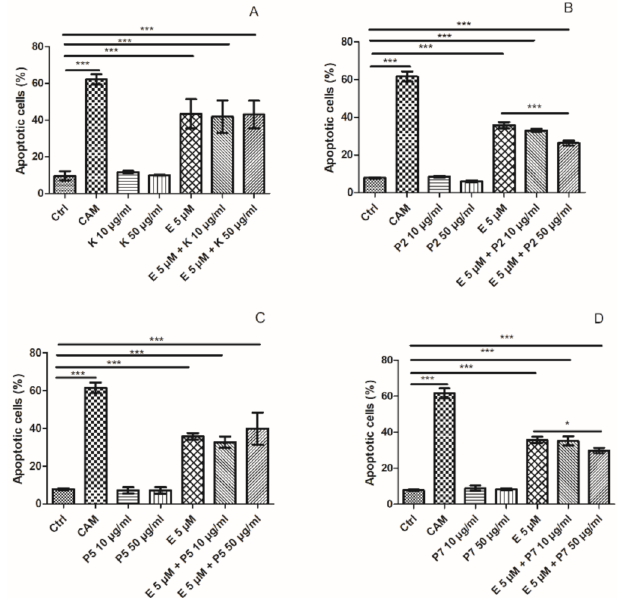
Figure 6. Apoptosis measured by flow cytometry using a double staining of FITC Annexin V and propidium iodide in HL-60 cells incubated for 24 h at 37 ◦ C with 5 µ M etoposide (E) and 10 or 50 µ g/mL kaempferol (K) ( A ), P2 ( B ), P5 ( C ) and P7 ( D ) derivatives. The cells incubated with 20 µ M camptothecin (CAM) for 24 h at 37 ◦ C were positive control. The figure shows mean results ± SD, n = 3; * p < 0.05, *** p <